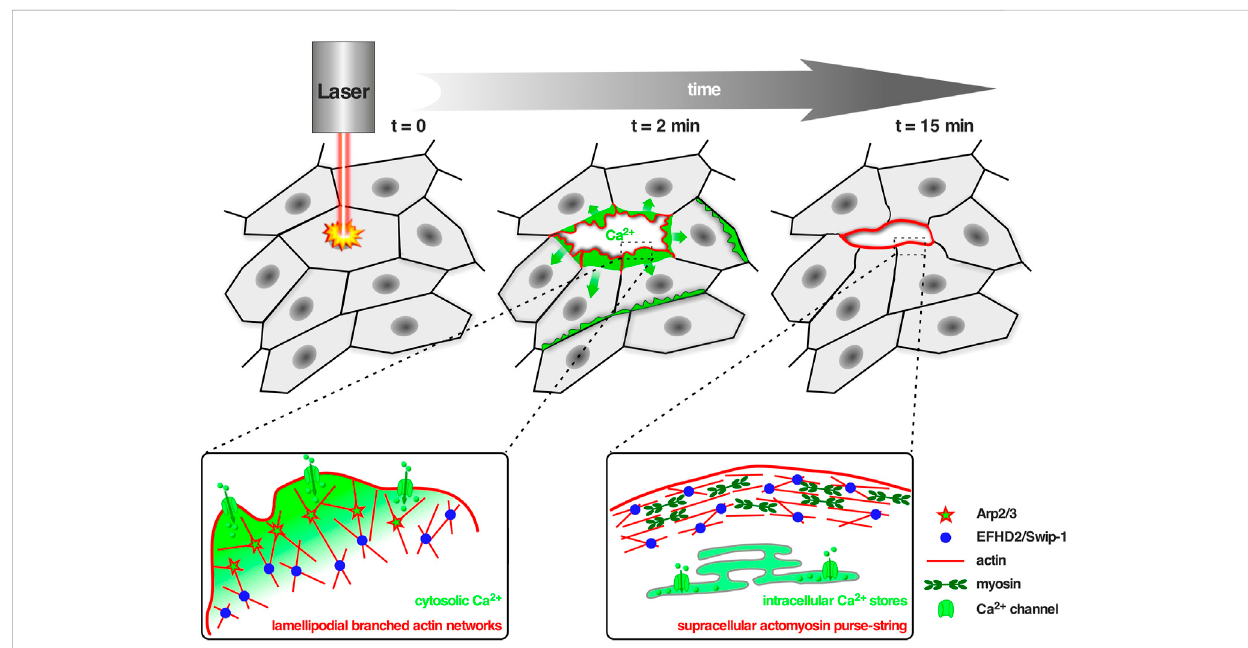
FIGURE 2 Swip-1 cross-linked lamellipodial actin networks drive single cell migration and epithelial wound closure. Upper panel: Schematic of the in vivo modeltostudycalcium-dependentwoundhealingintheabdominalepidermisin Drosophila .Laser-inducedsingle-cellablationstartsat t =0 min.Inthe fi rst two minutes ( t = 2 min) F-actin assembled into broad lamellipodial protrusions within cells at the wound edge; lamellipodial protrusions reached a maximum size between 5 – 10 min after wounding. Later on ( t = 15 min) lamellipodia formation decreased and a supracellular acto-myosin ring is formed at the leading edge of the wound, contracted laterally to pull cells forward and increasingly contributes to wound closure. Lower panel: Schematic showing the proposed role of Swip-1 in regulating lamellipodial actin networks and supracellular acto-myosin rings upon laser-induced single-cell wounding within the epidermis (see also text; adapted from Lehne et al., 2022). Left: The actin crosslinking activity of Swip-1 (blue spheres) synergizes with WRC-Arp2/3-branched actin nucleation (red stars) promoting generation of a stable and densely branched actin fi lament network. Plasma membrane damage or mechanical activation of calcium channels (green) allows arapid reorganization of the actin cytoskeleton through Swip-1. Right: After initial calcium wave propagation, the levels of intracellular calcium decreased mediated by special pumps (green) like the sarcoendoplasmic reticular calcium ATPases (SERCA) which constantly remove calcium from the cytoplasm to the ER lumen. A supracellular actin-myosin ring is formed stabilized by stable actin cross-links induced by